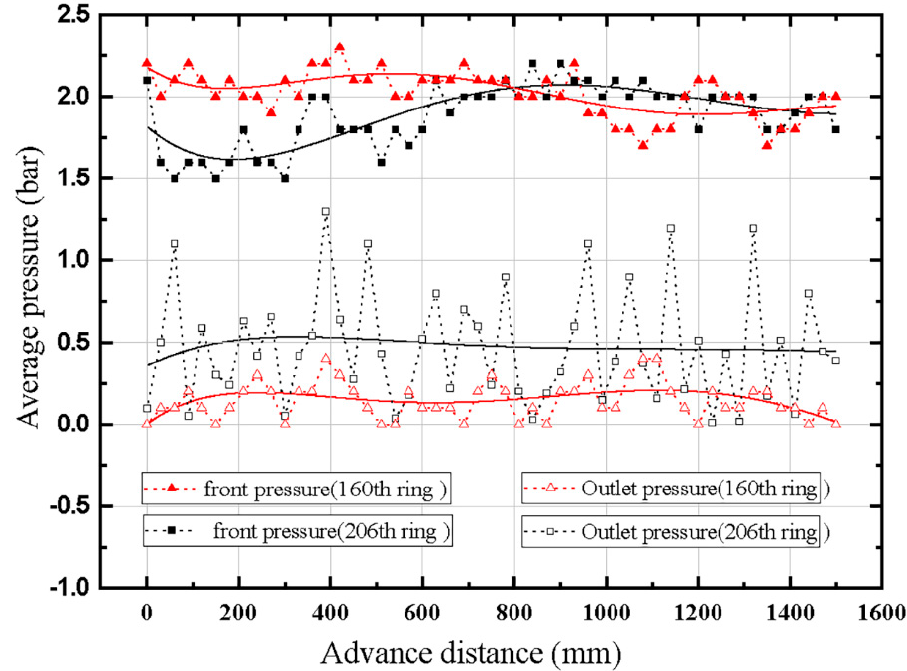
Figure 10. Changes in P o and P f with forward distance during the excavation of the 160th and 206th rings.